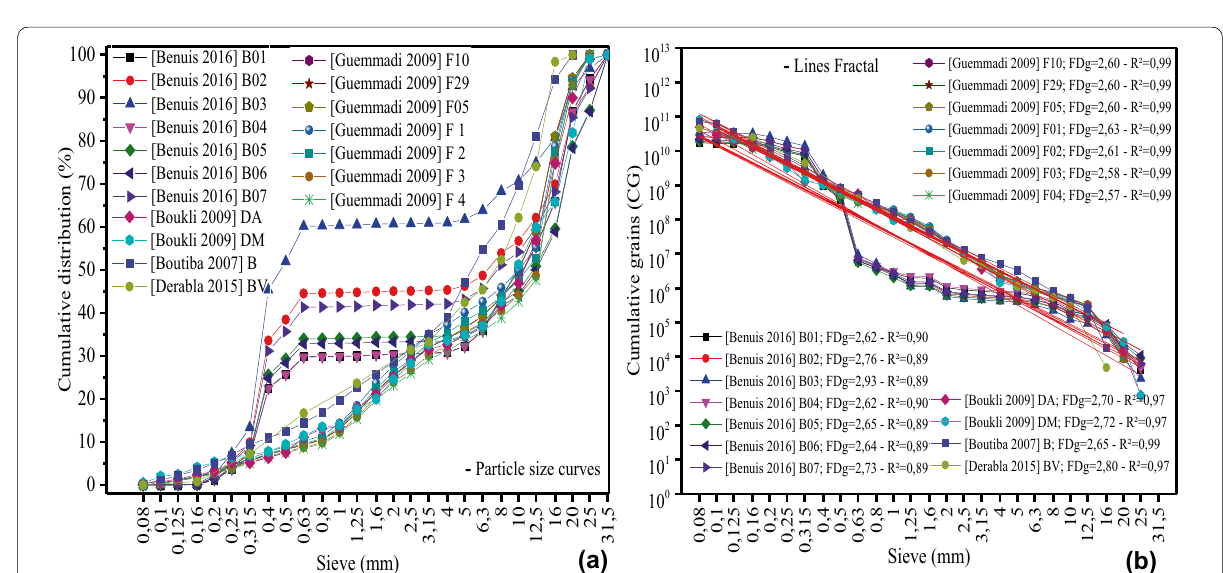
Fig. 5 Transformation of grain size curves into fractal lines (collected data). a Grain size curves, b fractal straight